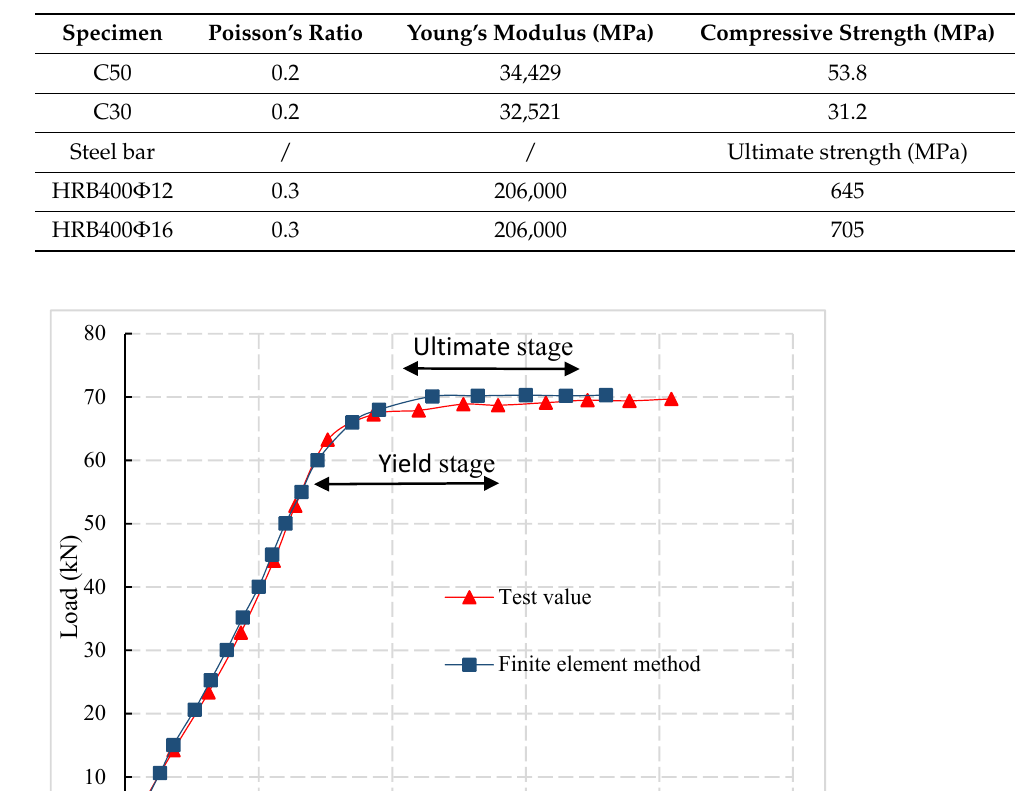
Table 4. Material properties of concrete and reinforcement.